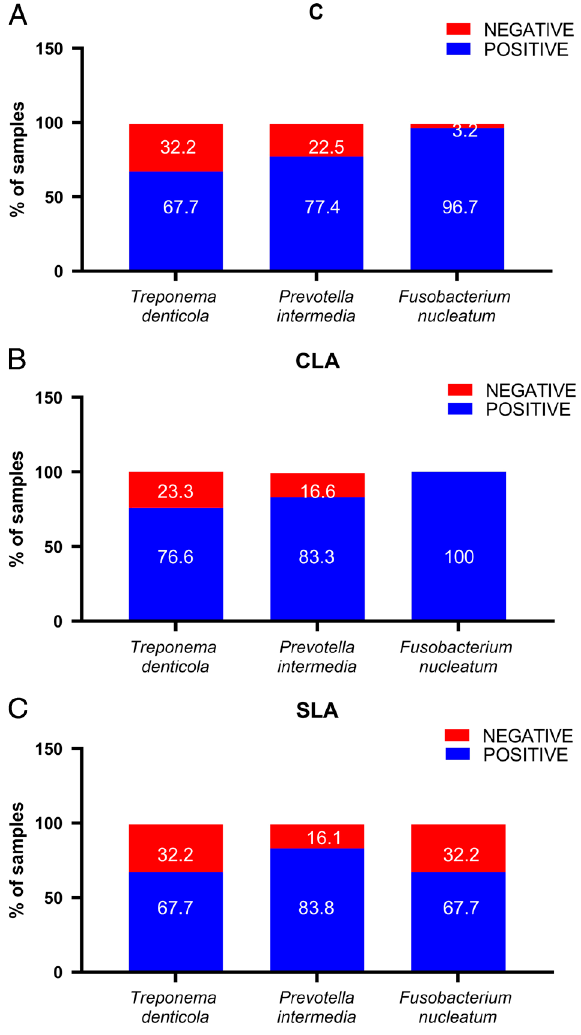
Figure 2. A, Presence of bacteria in C group. B, The bacterial presence of F. nucleatum is significantly higher in the CLA group displaying 100% of positivity when compared to SLA. C, Bacterial presence is lower in the SLA